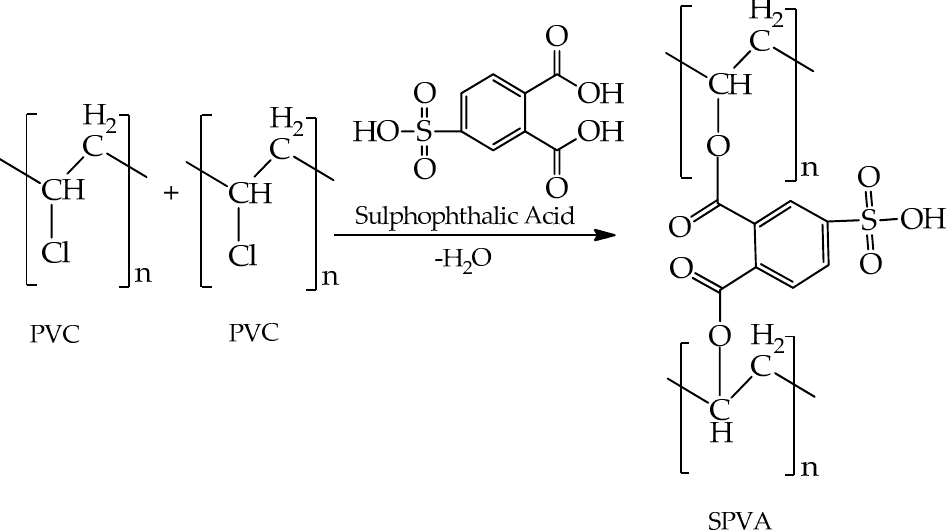
Figure 1. Scheme representing the mechanism of formation of the SPVC polymer